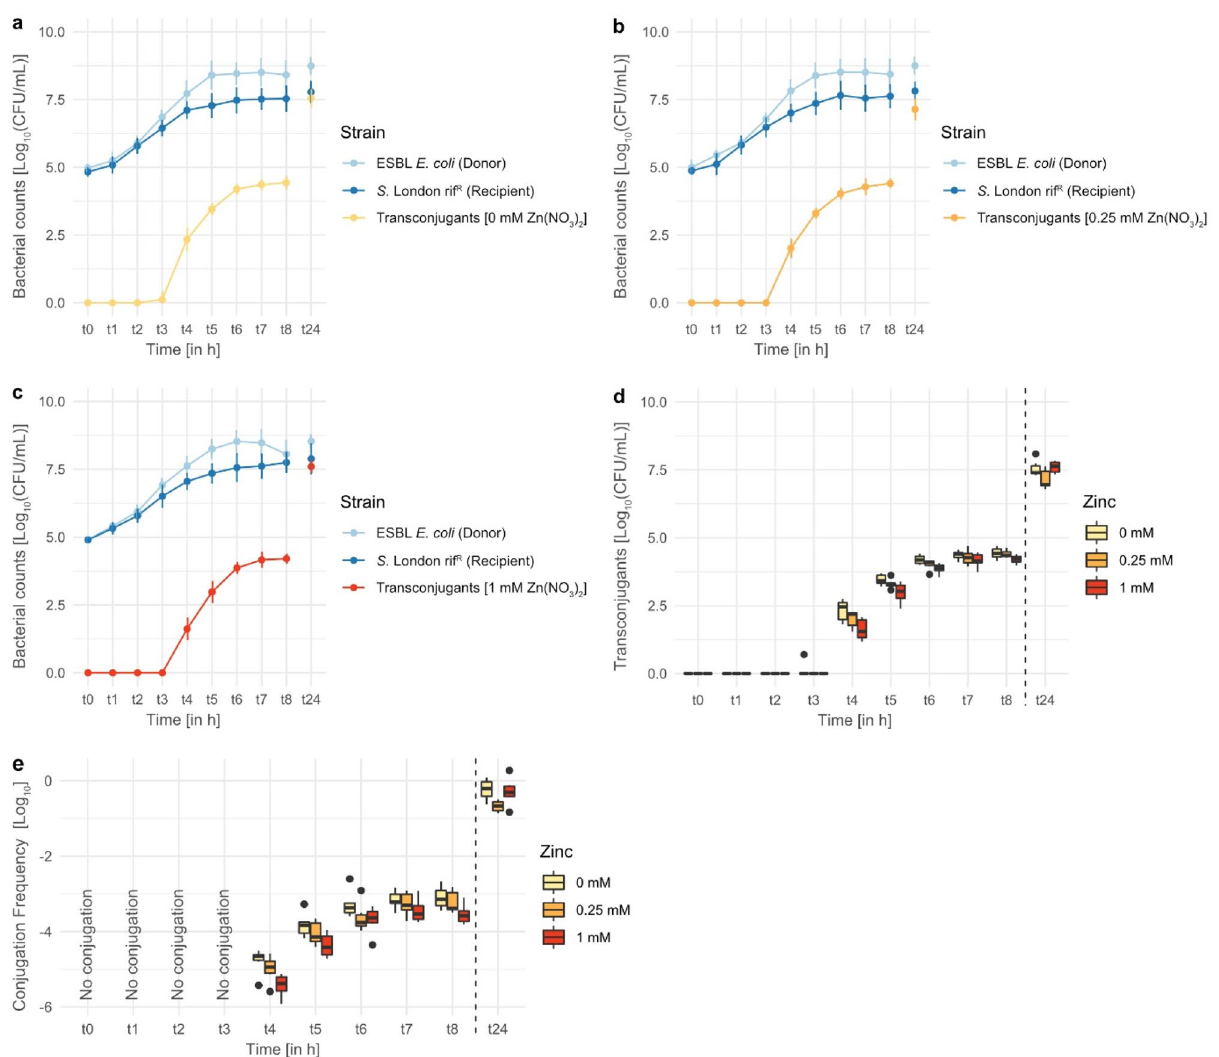
Figure 2. Transconjugant, donor, and recipient numbers during exposure to ( a ) 0 mM, ( b ) 0.25 mM, and ( c ) 1 mM of Zn(NO 3 ) 2 , from inoculation [t0] measured hourly for 8 h [t8] and additionally measured after 24 h [t24]. ( d ) Transconjugant numbers and ( e ) conjugation frequencies at different concentrations of Zn(NO 3 ) 2 . Pairwise comparison of transconjugant numbers and conjugation frequencies at different concentrations was performed via Student’s T -test. P -values were adjusted using the Bonferroni correction. No significant differences were